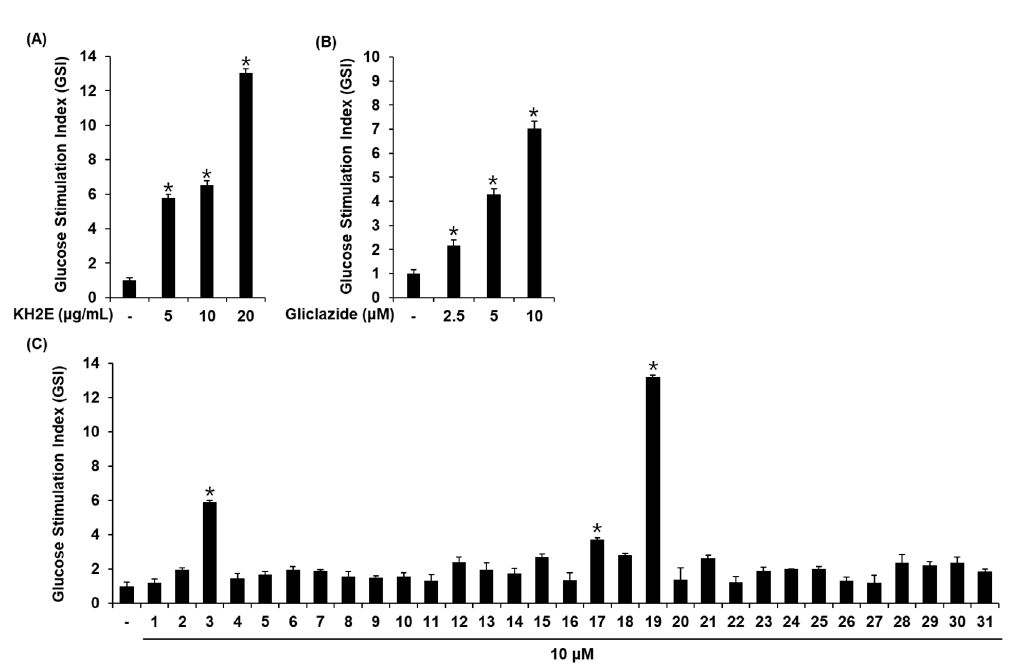
Figure 5. E ff ects of KH2E and compounds 1 – 31 on glucose-stimulated insulin secretion in INS-1 cells. Insulin secretion after 1 h treatment with 2.8 mM and 16.7 mM glucose in the presence or absence of ( A ) KH2E, ( B ) gliclazide, and ( C ) compounds 1 – 31 , as determined by the insulin secretion assay. Data represent the mean ± S.E.M., n = 3, * p < 0.05 compared with control.